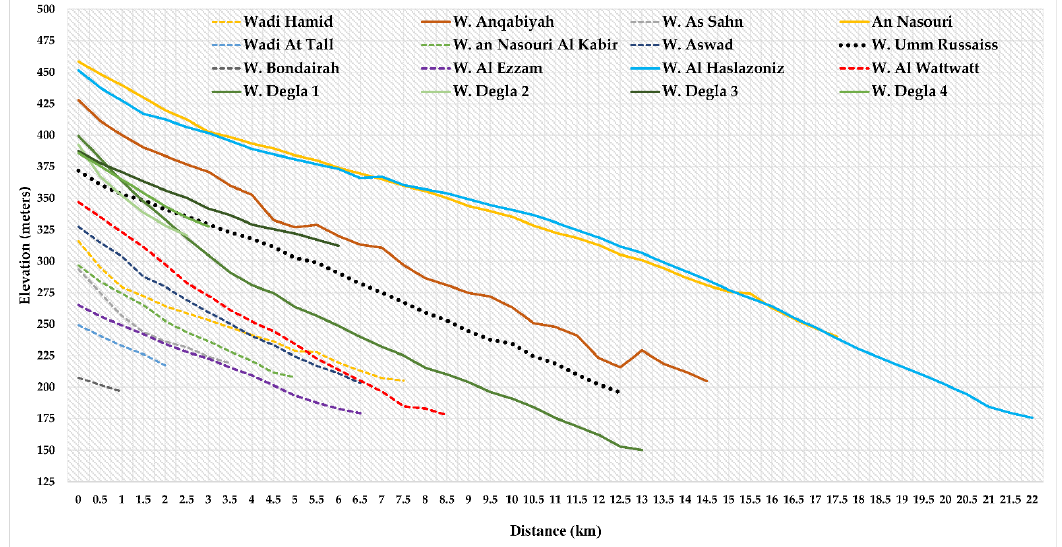
Figure 12. The longitudinal topographic profiles of the main active channels of watersheds in the study area.